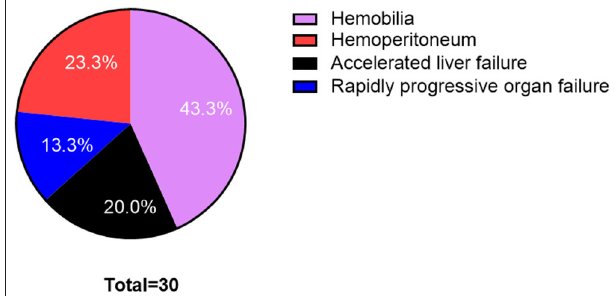
FIGURE 1 | Proportion figure of postoperative complications in transjugular intrahepatic portosystemic shunt (TIPS) procedure.